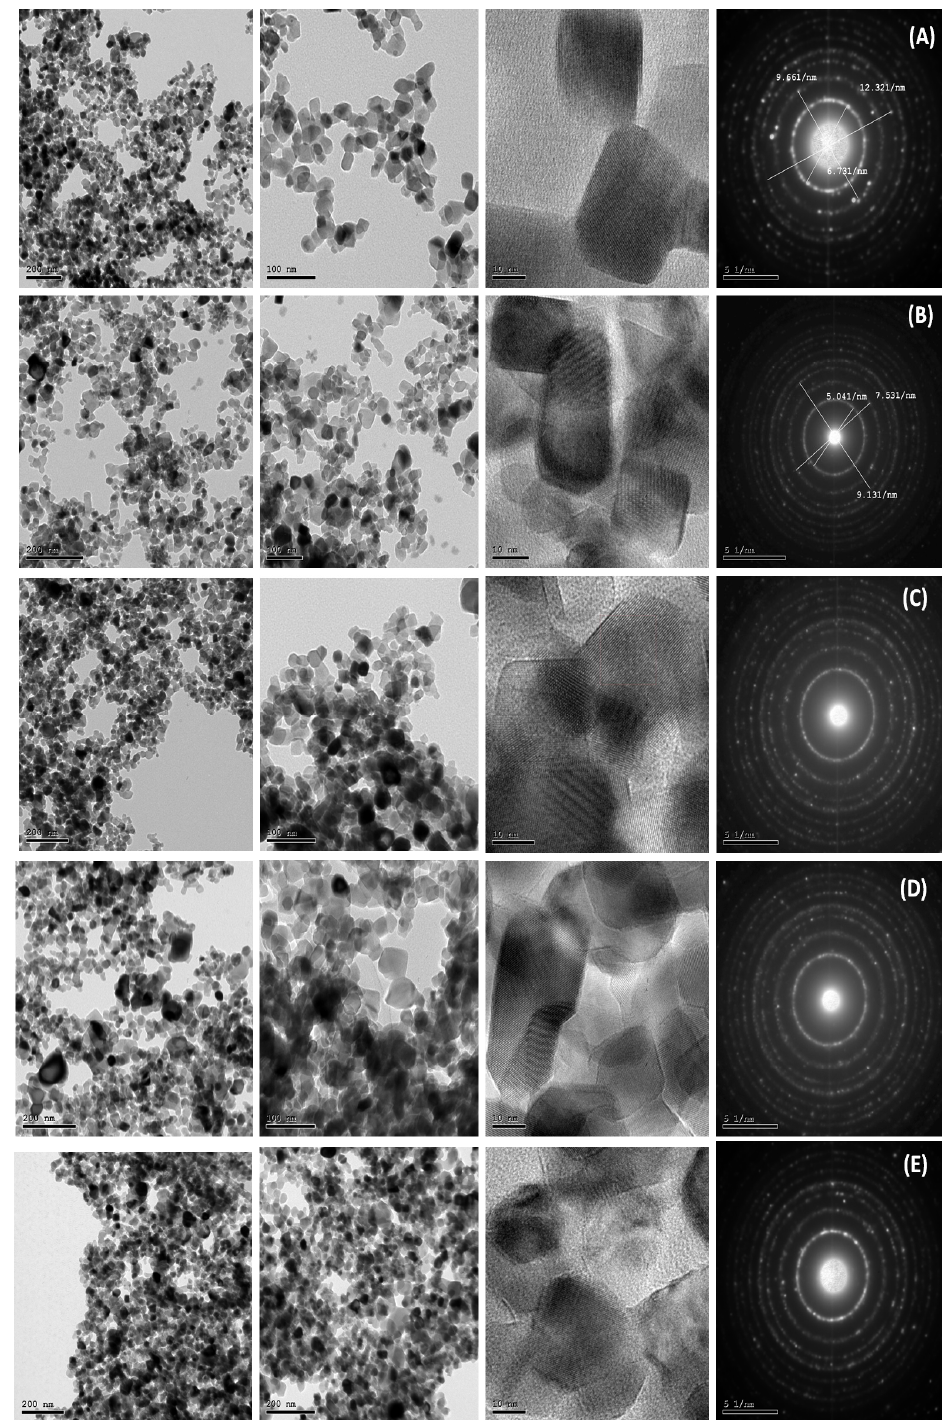
Figure 1. TEM, HRTEM images and SAED patterns of ( A ) 1% Pd/TiO 2 , ( B ) 1% Cu/TiO 2 , ( C ) 0.75Pd-0.25Cu/TiO 2 , ( D ) 0.25Pd-0.75Cu/TiO 2 ( E ) 0.5Pd-0.5Cu/TiO 2 . Figure 2 displays the X-ray diffraction patterns of 1% Pd/TiO 2 , 1% Cu/TiO 2 , 0.75Pd- 0.25Cu/TiO 2 , 0.25Pd-0.75Cu/TiO 2 , and 0.5Pd-0.5Cu/TiO 2 . Pure anatase TiO 2 (JCPDS # 01- 075- 2545) is observed in all samples indicating that its crystallinity is not affected by pres- ence of Pd and Cu NPs. The absence of the Pd and Cu NPs was also demonstrated by the